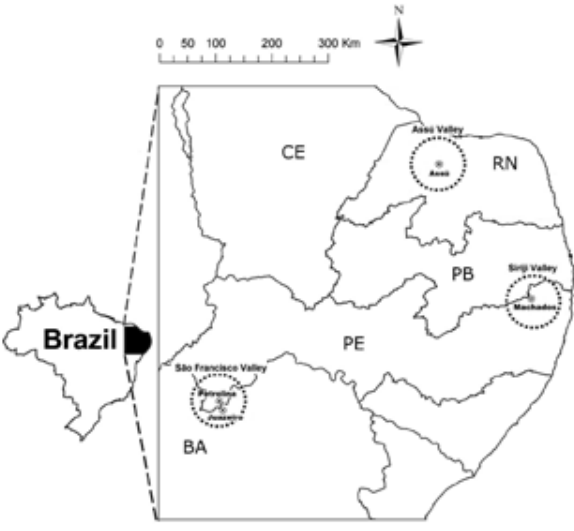
Figure 1. Table grape growing areas surveyed in North - eastern Brazil (the São Francisco, Assú and Siriji Valleys) in